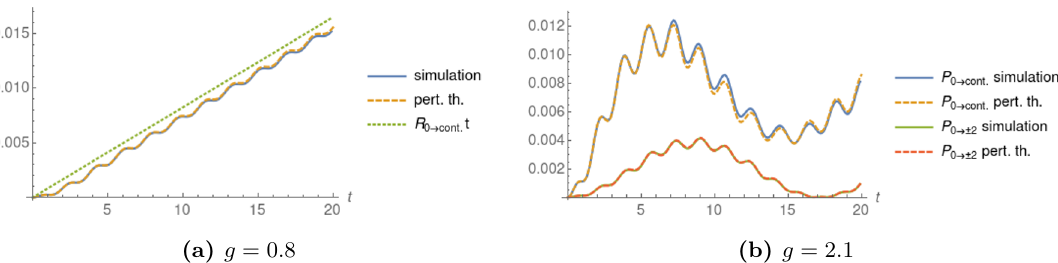
Figure 2. Transition probabilities from the zero mode to continuum and bound states for a perturbation with amplitude A = 0 . 1 . We compare simulation results with first-order perturbation theory. The rate from the zero mode to the continuum (eq. (3.3)) is also shown in (a) with the dotted